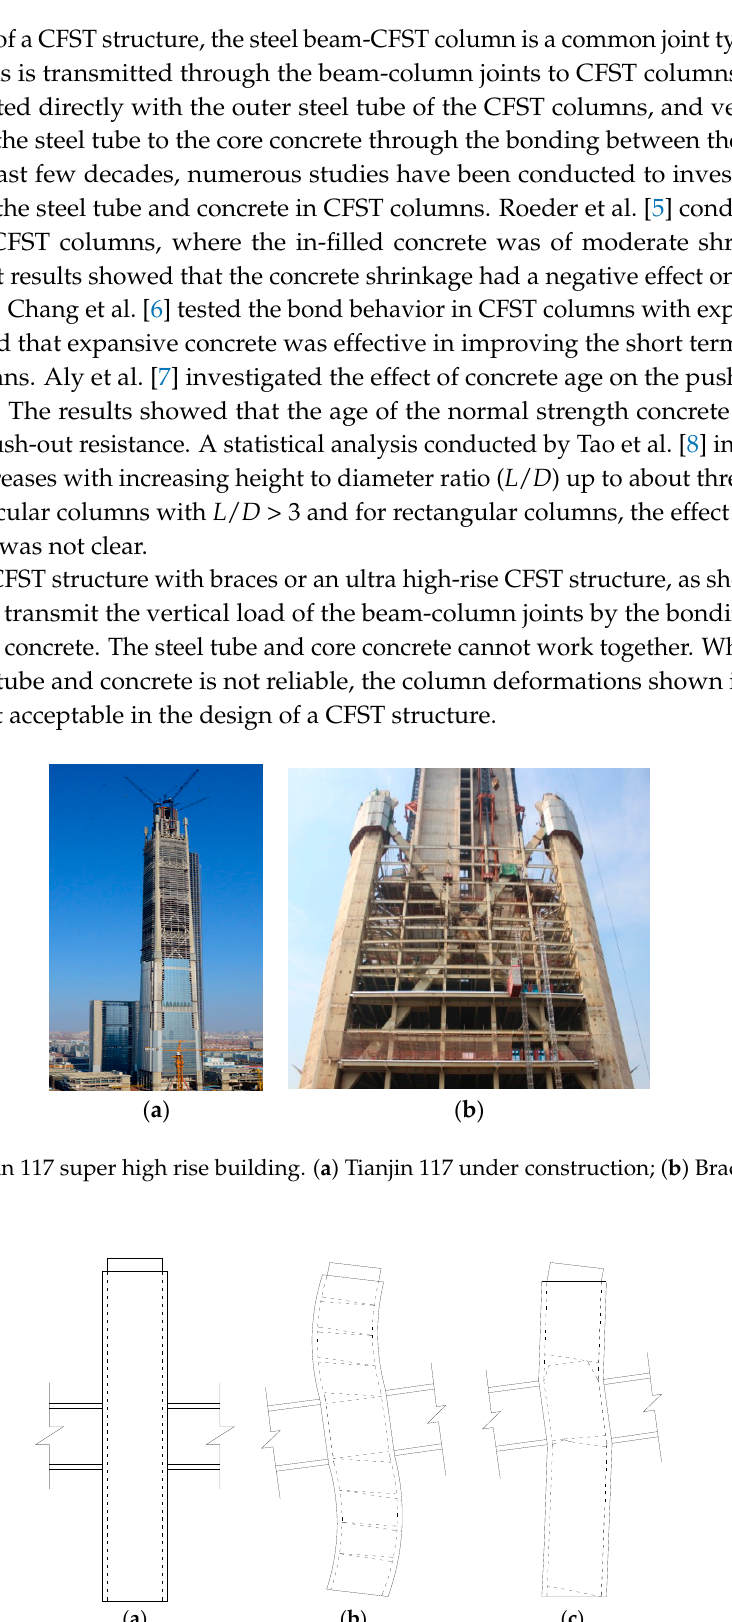
Figure 2. Deformation and slippage of concrete filled steel tube (CFST) column when bonding is not reliable. ( a ) Axial deformation; ( b ) Bending deformation; ( c ) Shear deformation.